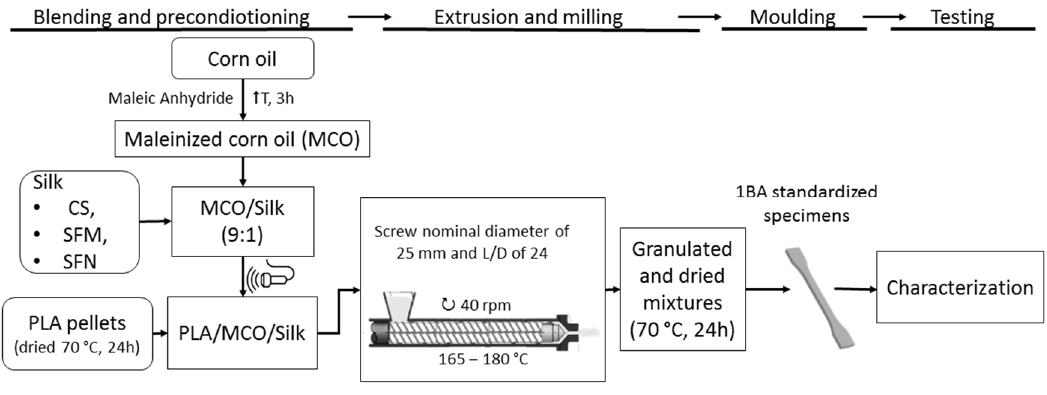
Figure 3. Flow chart of the process used for the preparation of PLA-MCO-Silk composites.